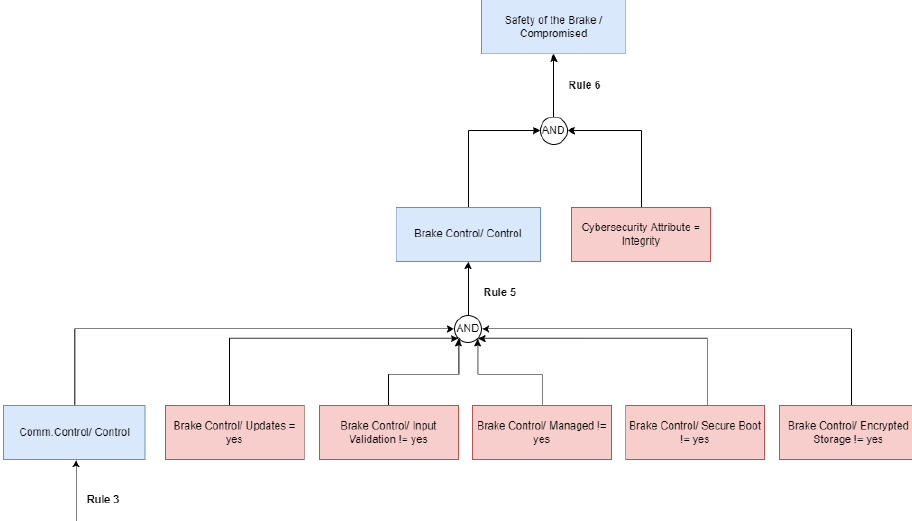
Figure 19. Sub-tree for reaching the safety of the brake